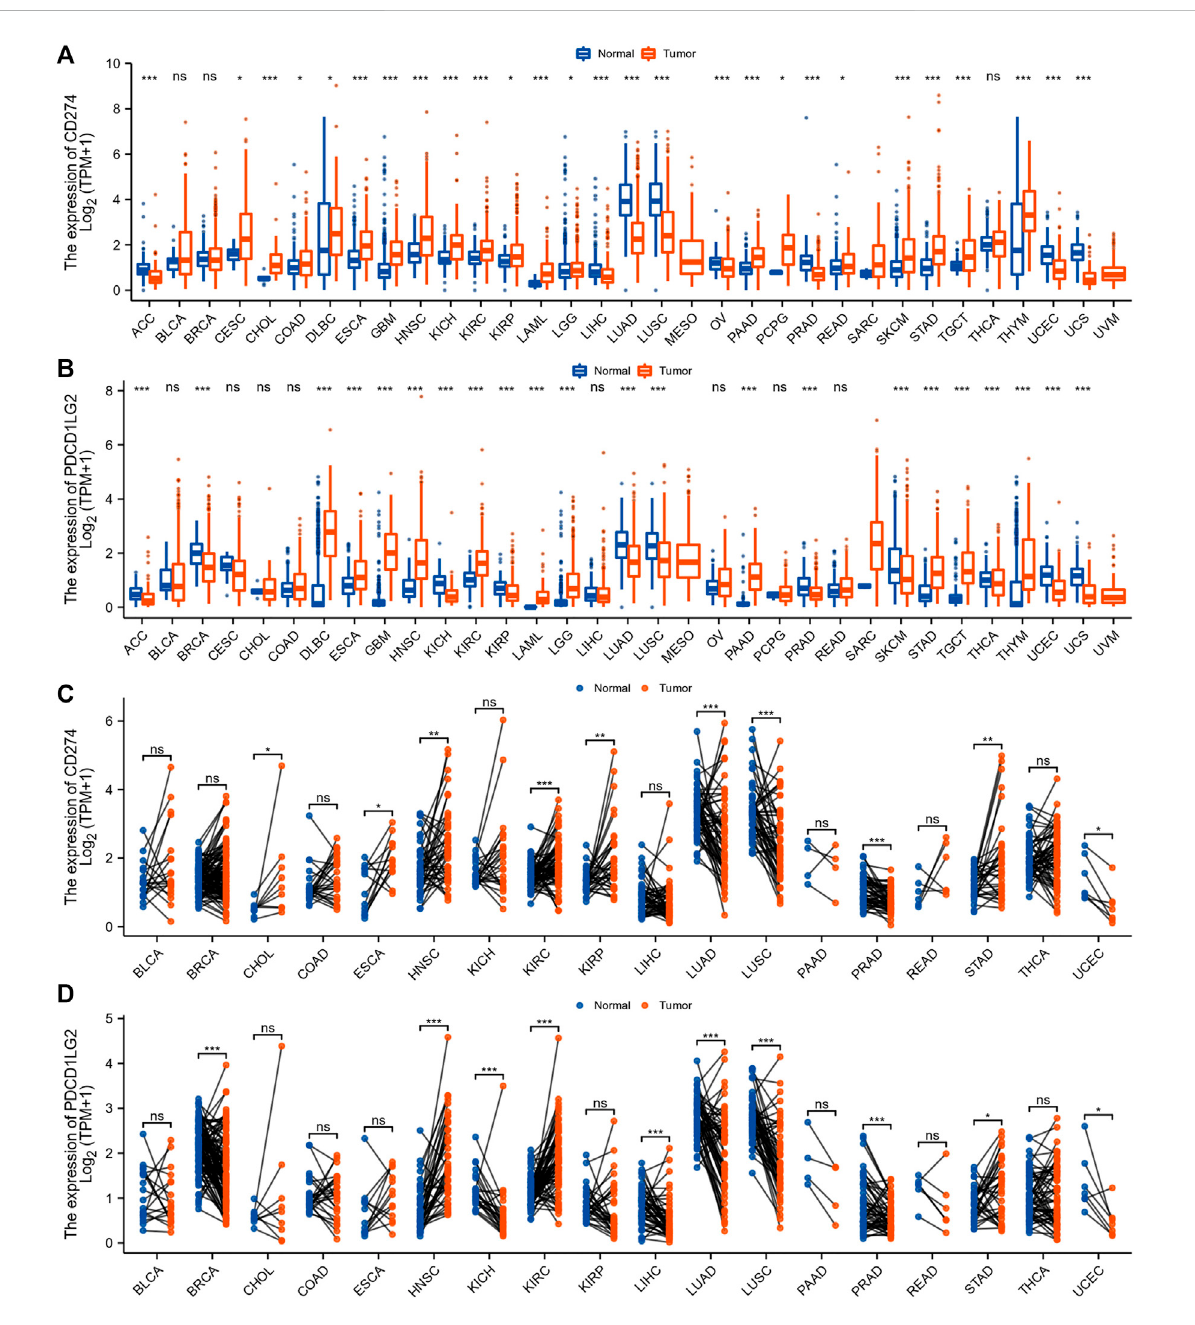
FIGURE 1 CD274andPDCD1LG2expressionindifferentcancertypes. (A,B) CD274andPDCD1LG2levelsinTCGAtumorsamplesandnormaltissueswith samples in the GTEx database as controls. (C,D) Expression of CD274 and PDCD1LG2 in tumor samples and paired adjacent tissues from the TCGA. (* p < 0.05, ** p < 0.01, *** p <